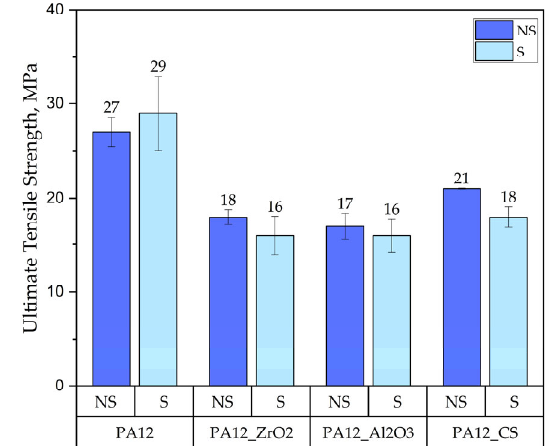
Figure 5. Ultimate tensile strength of the PA12, PA12_ZrO 2 , PA12_Al 2 O 3 and PA12_CS samples in their non ‐ sterilised/in initial state and after sterilisation.